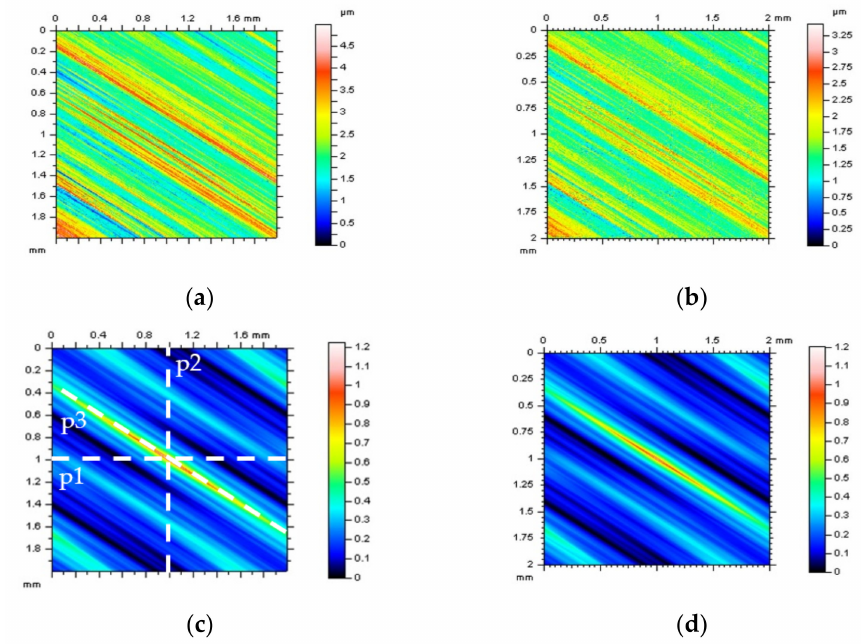
Figure 7. Countour map plots ( a , b ) of ground surface texture and their ACFs ( c , d ) for raw measured data (left column) and data containing high-frequency errors (right column); in Figure 7c the direction of profile extraction, widely presented in Figure 8, was